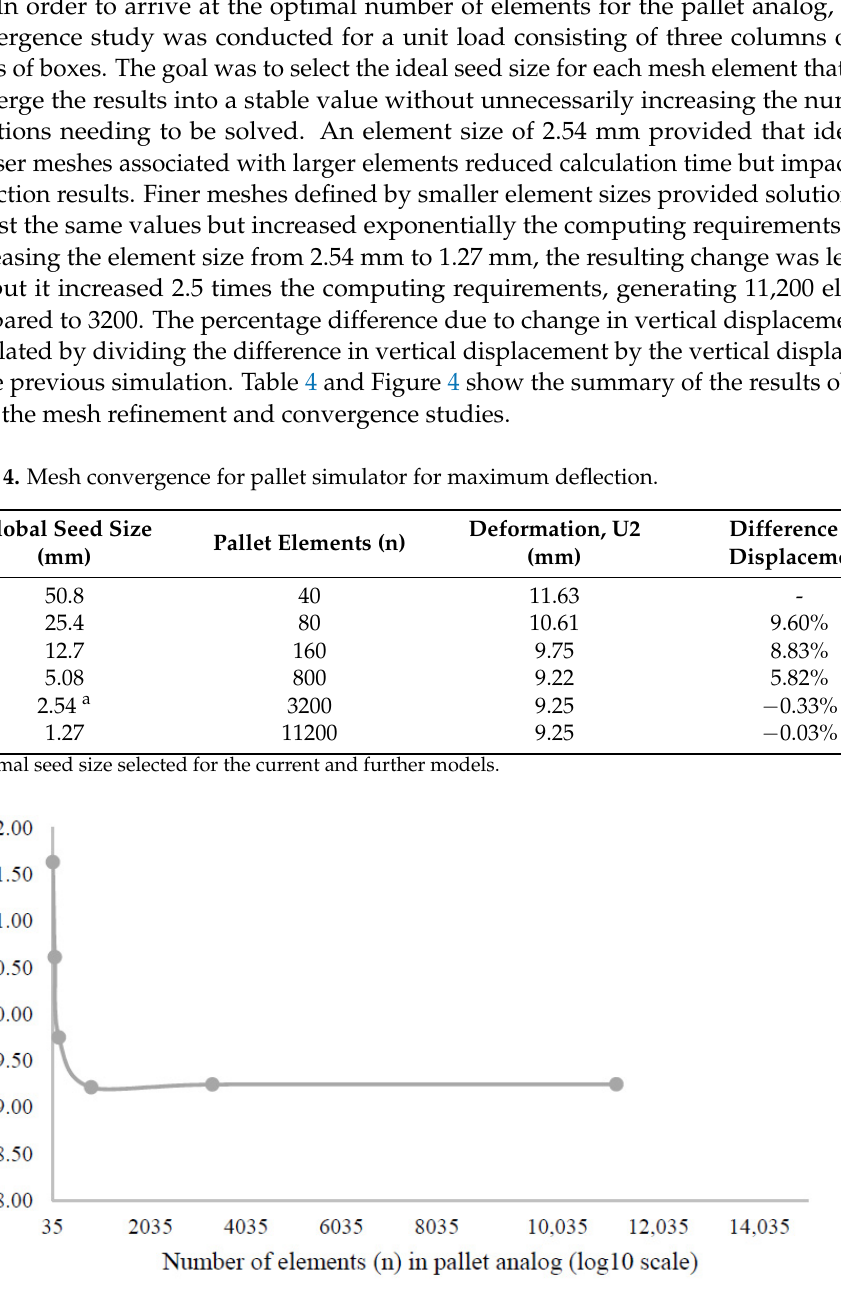
Figure 4. Pallet simulator mesh convergence results for 3 columns, 3-layer unit load. Maximum pallet deflection (U2, mm) at the board midspan versus total number of elements.